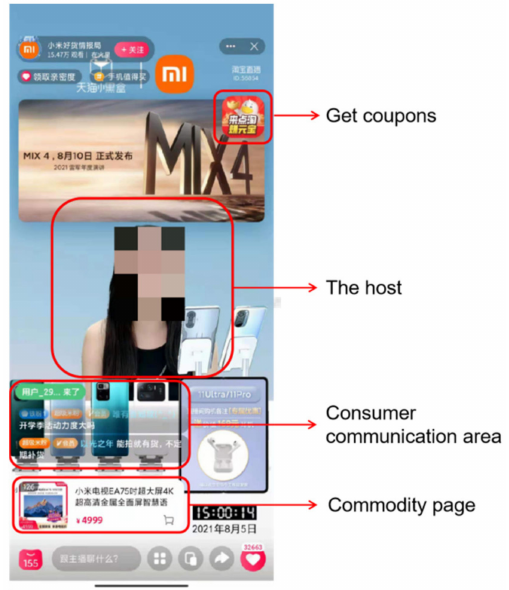
Figure 1. An e-economic live streaming page in